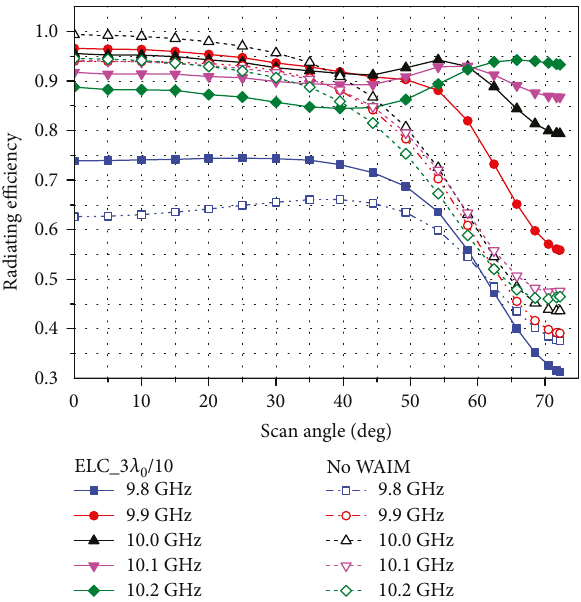
Figure 9: Simulated e ffi ciency versus scan angle in the case without WAIM and with ELC metasurface slabs of 3 λ